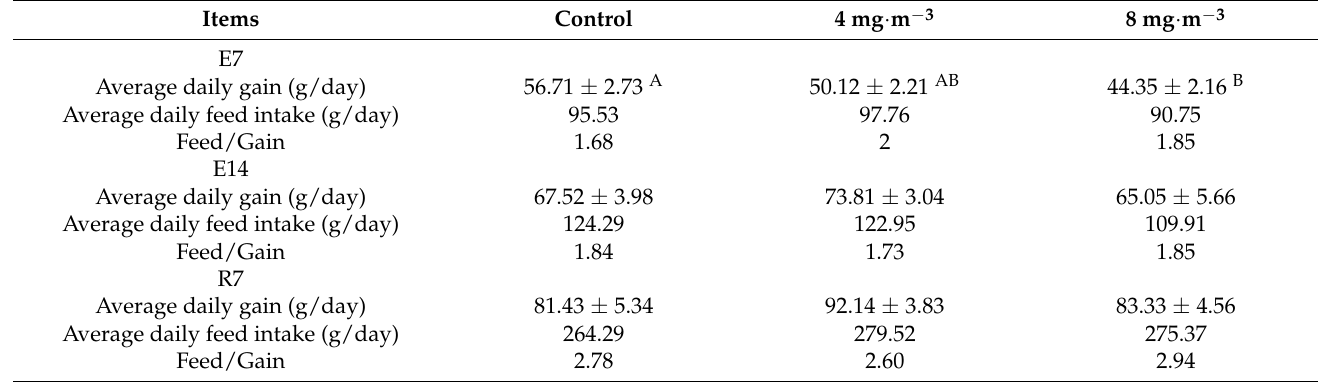
Table 1. Effects of particulate matter exposure on growth performance of